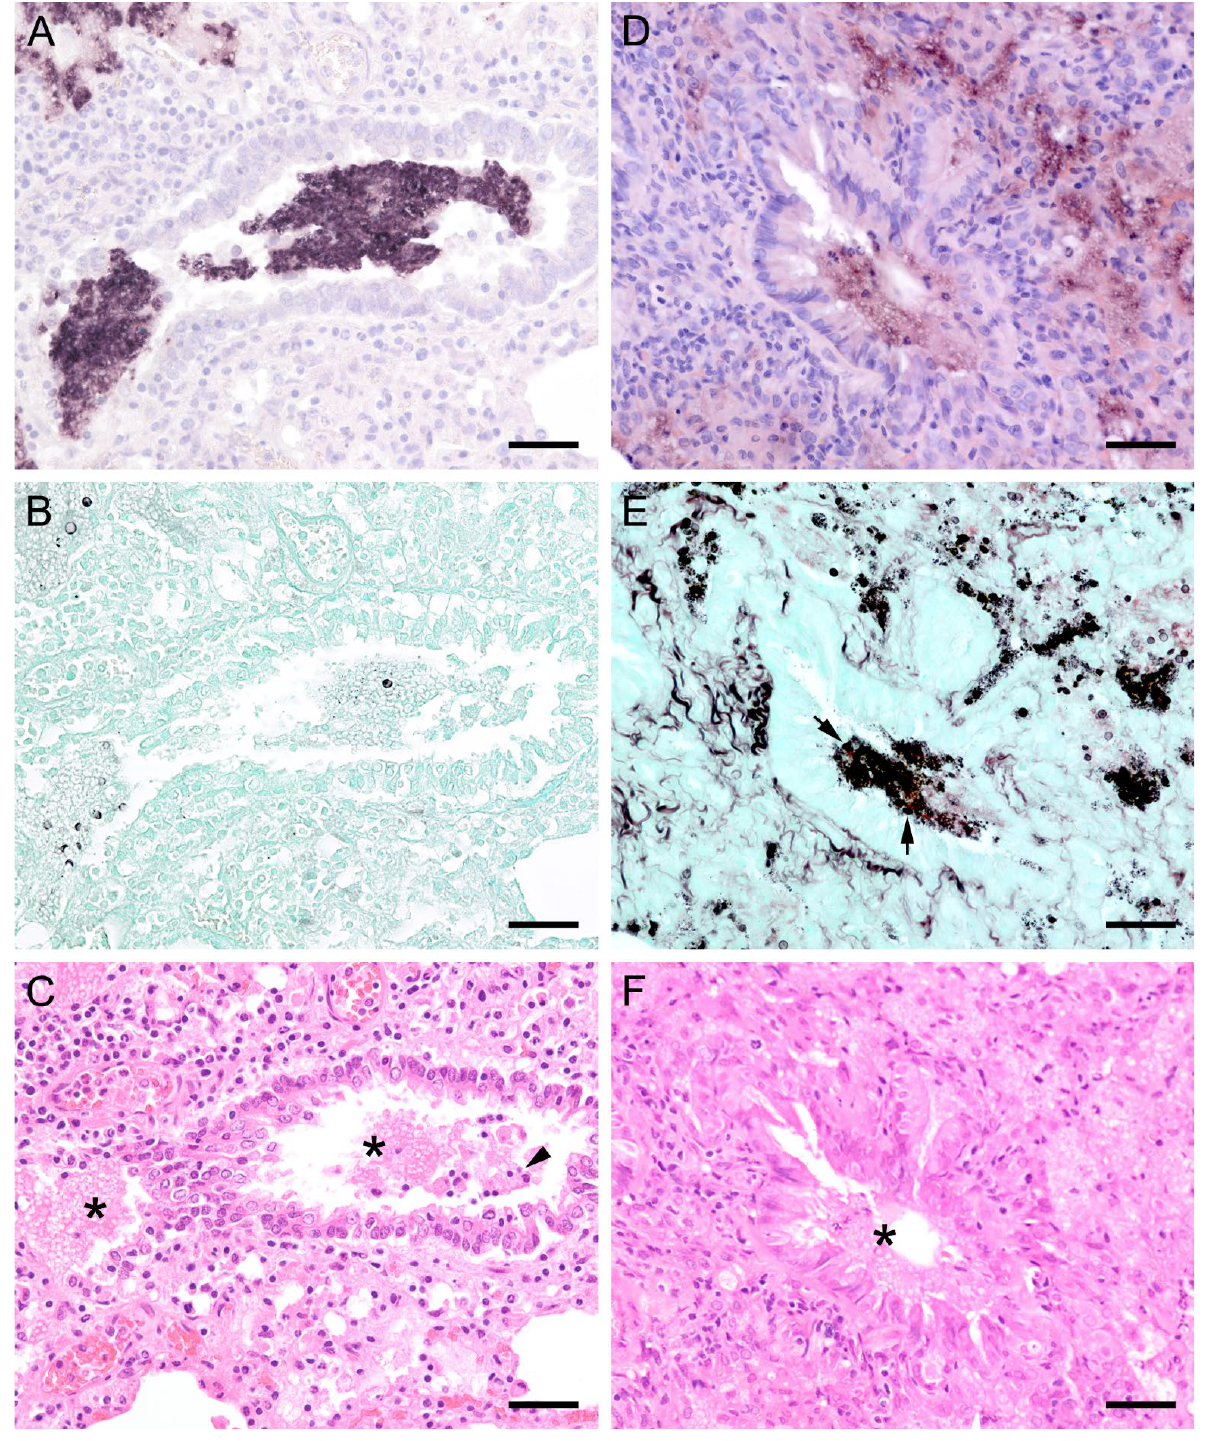
Figure 8. Adjacent sections from the same lung area of a pig and a laboratory rat with Pneumocystis organisms in bronchioles are shown in comparison after ISH, GMS, and H&E staining. ( A ) ISH labels a high number of organisms in a bronchiole of a pig. Bar = 40 µm; ( B ) The presence of asci is confirmed by GMS. Bar = 40 µm; ( C ) H&E staining reveals a mild bronchiolitis (arrowhead). The fungal organisms can also be identified histologically (asterisks). Bar = 40 µm; ( D ) ISH labels single organisms in the bronchiole of a laboratory rat. Bar = 40 µ m; ( E ) GMS labels single asci (arrows). Bar = 40 µ m; ( F ) The bronchiole is filled with fluid and Pneumocystis stages (asterisk). Bar = 40 µ